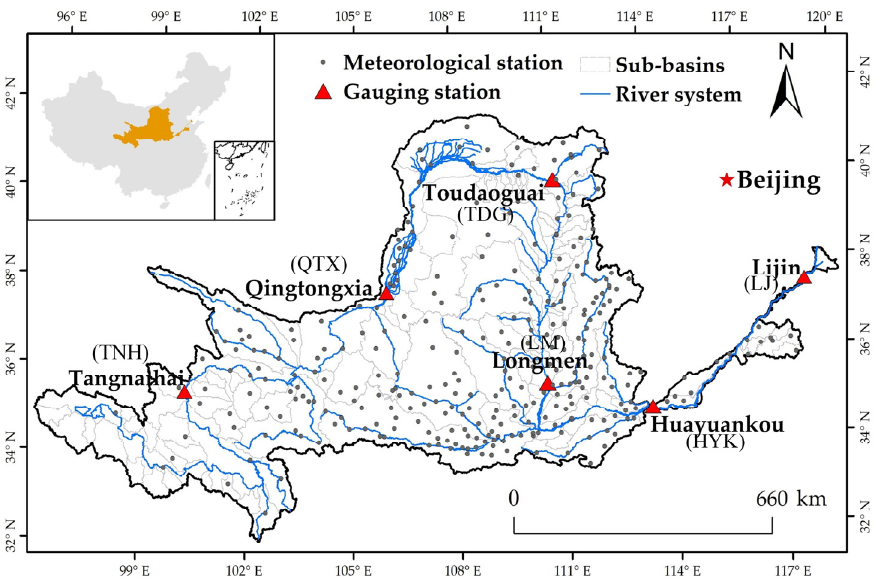
Figure 1. Spatial distribution of the meteorological and gauging stations in the YRB. The gauge stations are TNH, QTX, TDG, LM, HYK and LJ from upstream to downstream, respectively.